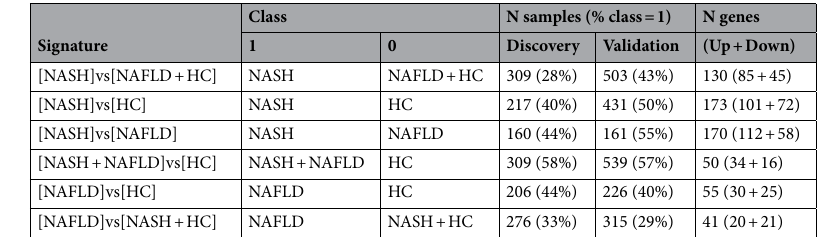
Table 2. Number of samples used for and genes identified in the six possible gene signatures. Class indicates the assignment to comparison groups in MetaIntegrator. HC healthy control.